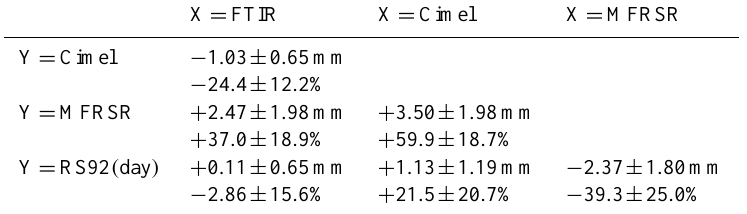
Table 4. Same as Table 3 but for the 101 occasions on with all the four experiments FTIR, Cimel, MFRSR and RS92 coincide within 1h. X = FTIR X = Cimel X = MFRSR Y =